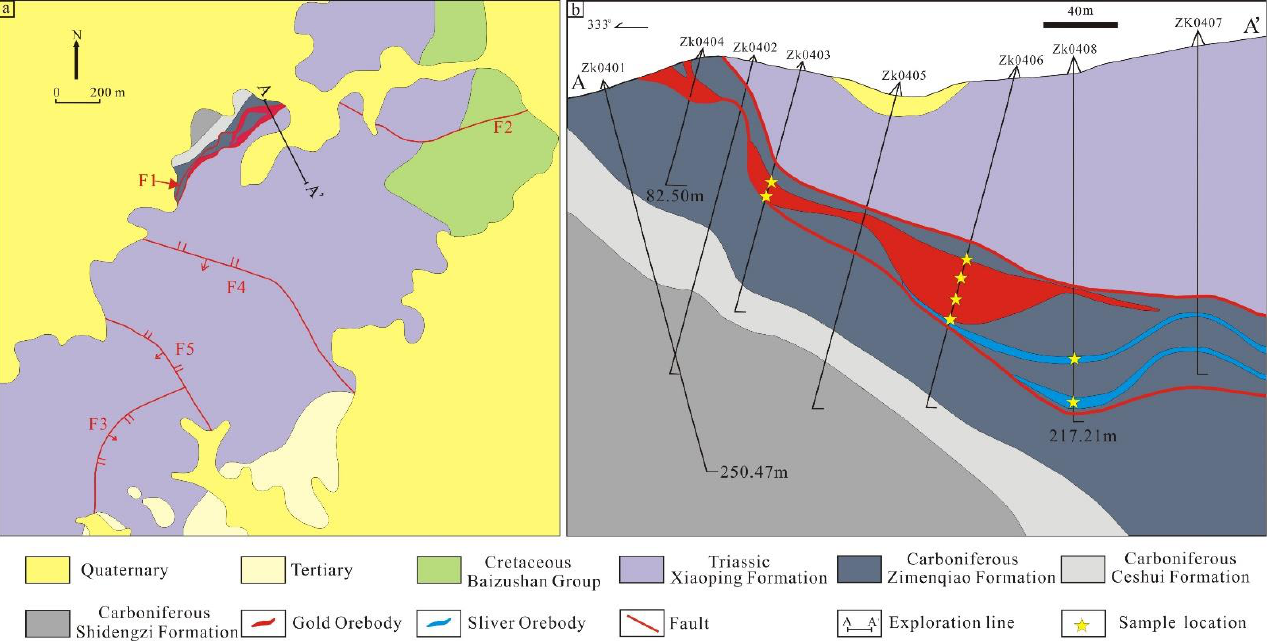
Figure 3. Geological sketch map ( a ) and geological cross section ( b ) of the Changkeng–Fuwan Au-Ag deposit (modified from [15]).